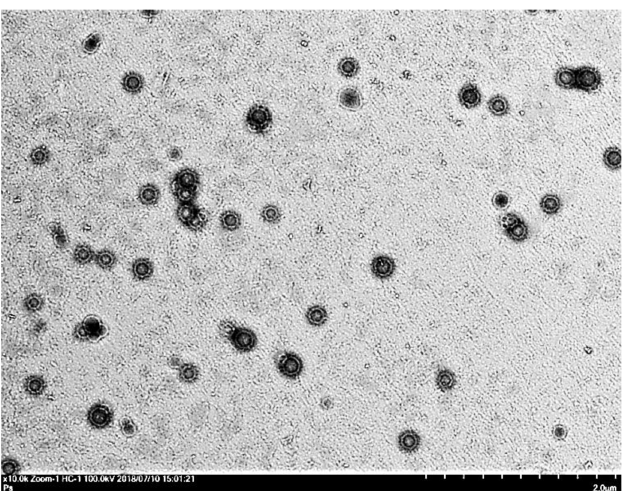
Figure 1. Transmission electron microscopy image of gemcitabine-loaded microemulsion of F3.